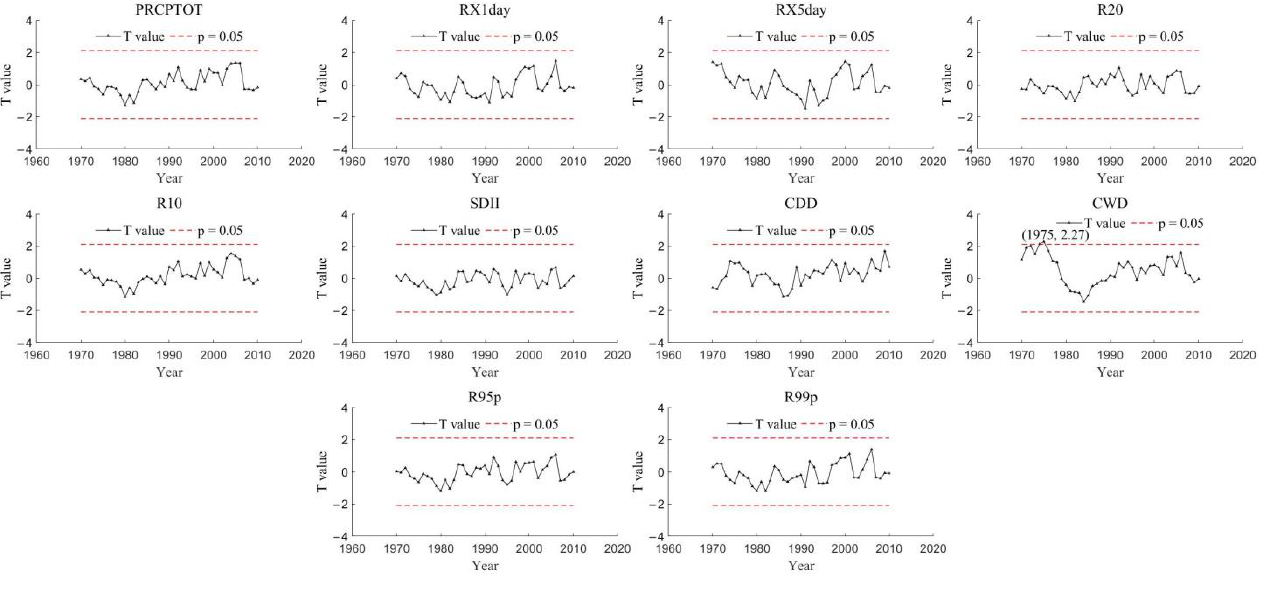
Figure 3. Moving T-test for each EPI within Hubei province on the annual scale during 1960 – 2019.